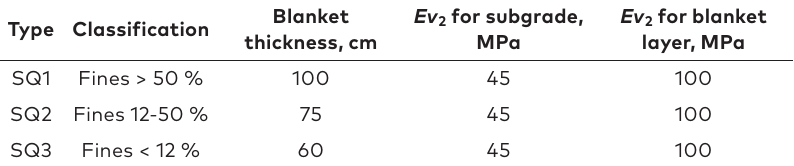
Table 2. Classification of soils & strain modulus as per GE-14, Indian Railways